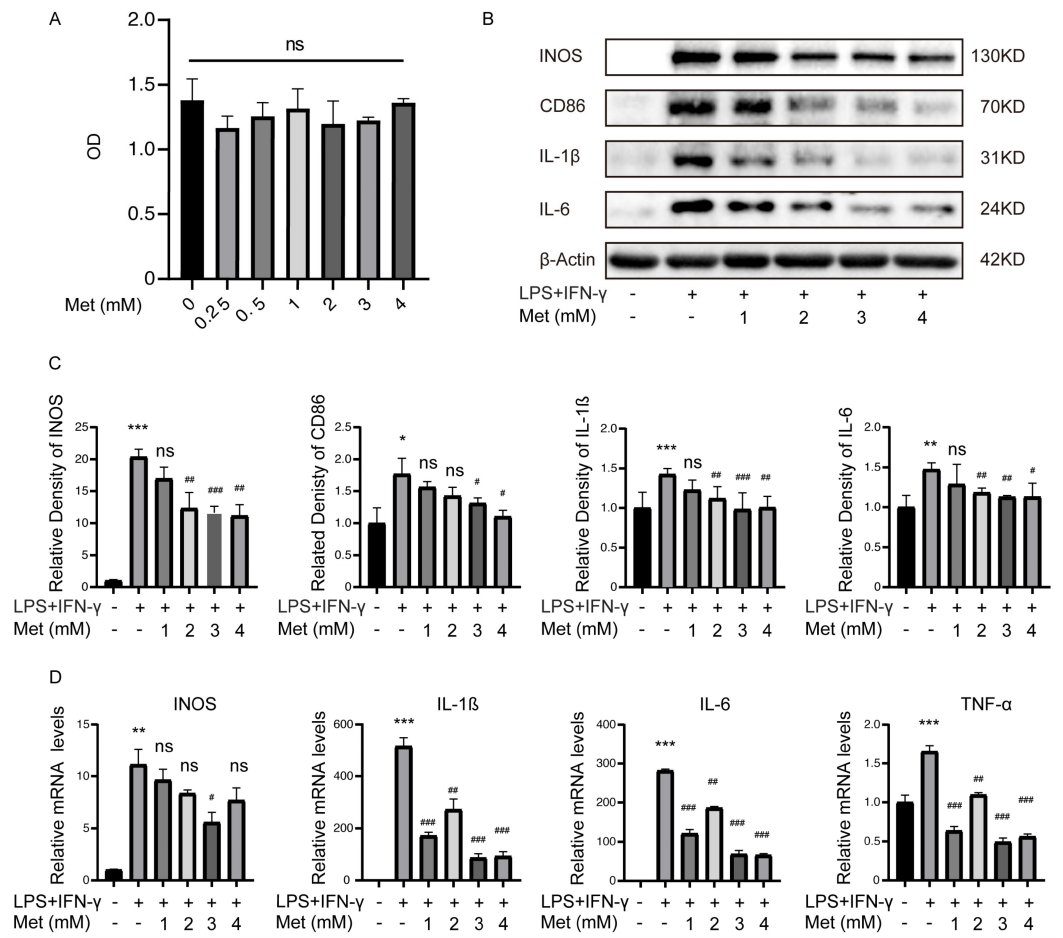
Figure 2. Metformin (Met) inhibits inflammatory cytokines levels produced by M1 macrophages. M1 macrophages were cultured with 0.25–4 mM metformin for 16 h. ( A ) Cell viability was determined via CCK-8 assay. ns > 0.05. ( B ) Representative Western blot and ( C ) quantitative analysis of INOS, CD86, IL-1ß, and IL-6. ( D ) mRNA levels of IL-1ß, IL-6, TNF- α , and INOS were determined via qRT-PCR. * p < 0.05, ** p < 0.01, *** p < 0.001 versus the vehicle-treated group. # p < 0.05, ## p < 0.01, ### p < 0.001 versus the LPS + IFN- γ treated